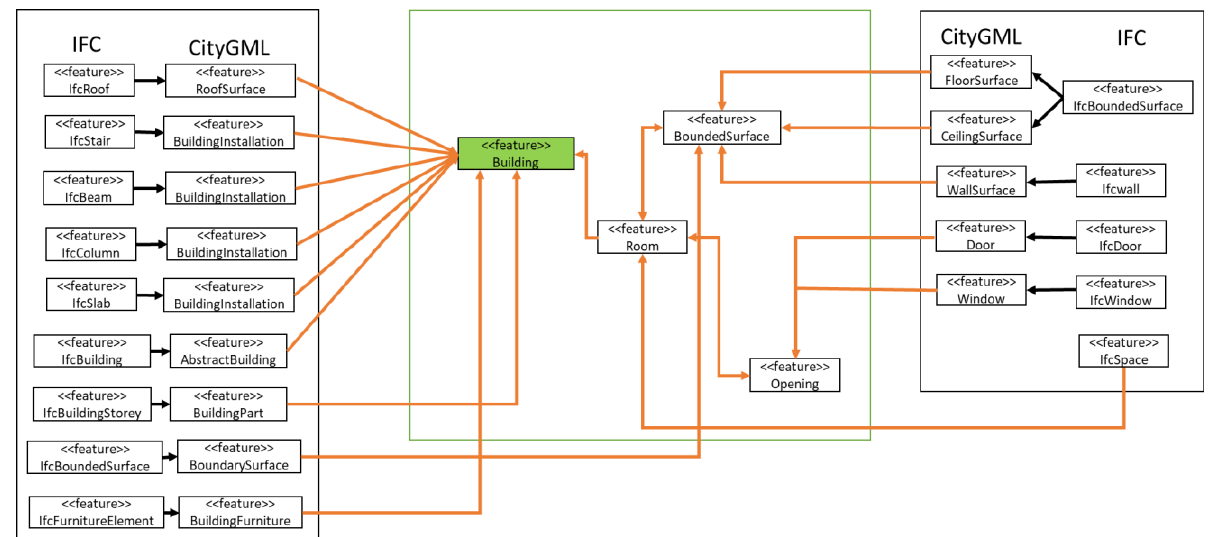
Figure 2. Mapping between IFC and